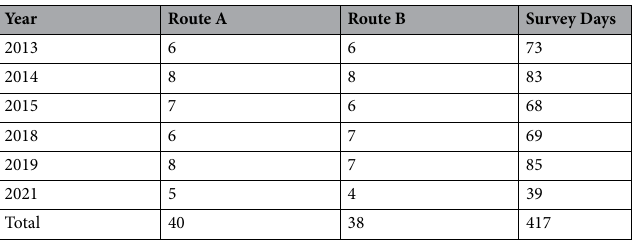
Table 2. Summary of the effort of surveys for Australian humpback ( Sousa sahulensis ) and Indo-Pacific bottlenose dolphins ( Tursiops aduncus ) around the North West Cape, Western Australia, indicating the number of repeats of the two opposing zigzag transect routes (Route A and Route B: see Fig. 1) and the number of survey